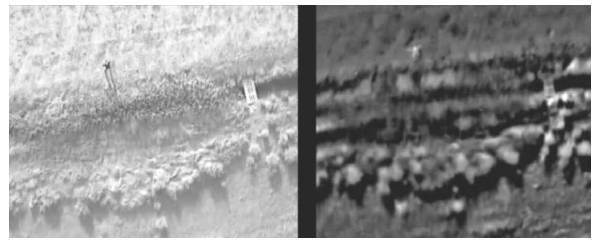
Figure 4: A person sensed by the RGB/thermal sensors. Video version at http://bit.ly/HN3efY